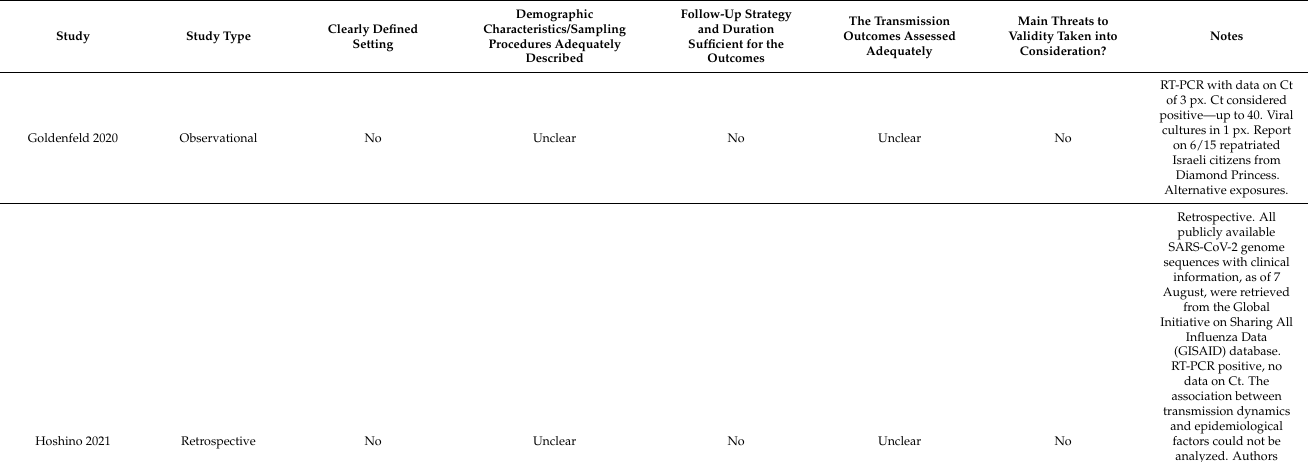
Table 4. Quality assessment of included studies reporting on onboard transmission of